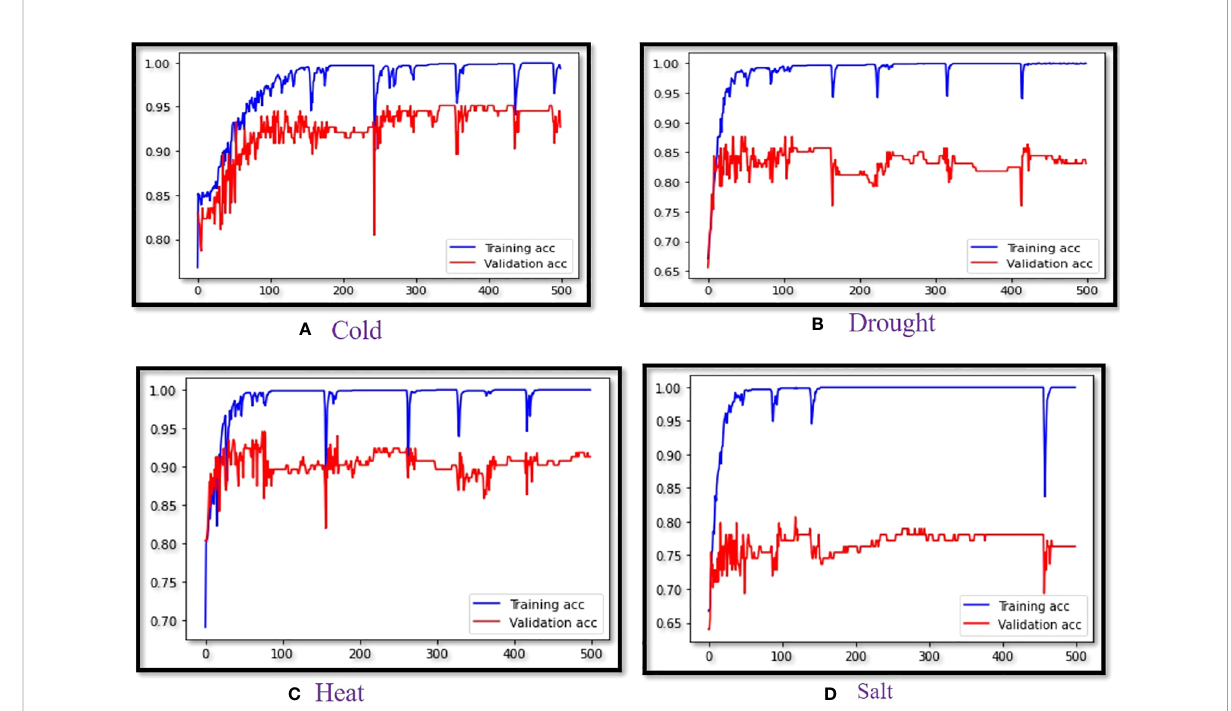
FIGURE 2 Validation curve of LSTM (SiELU) for (A) Cold stress , (B) Drought stress, (C) Heat stress and (D) Salt